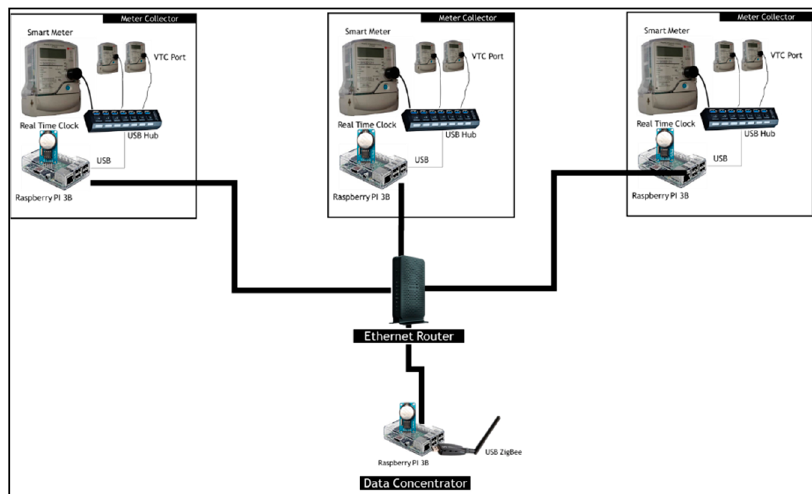
Figure 4. Proposed Architecture for Low Number of meters.